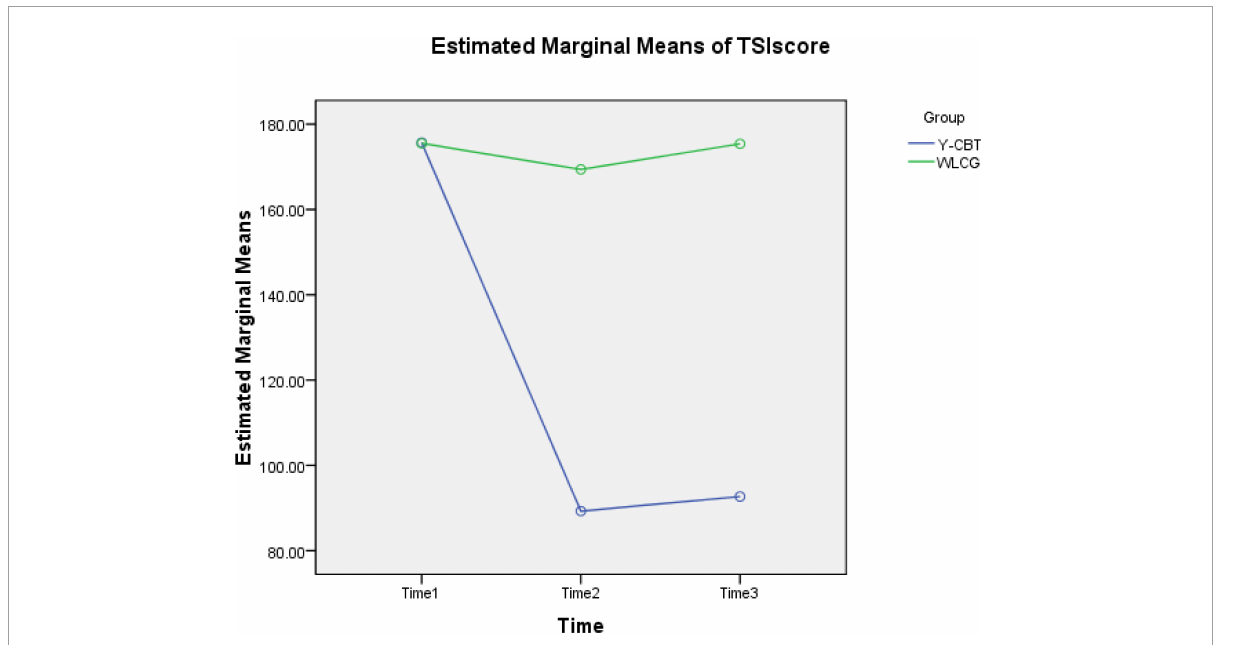
FIGURE5 Interaction effect of time and intervention on participants’ TSI